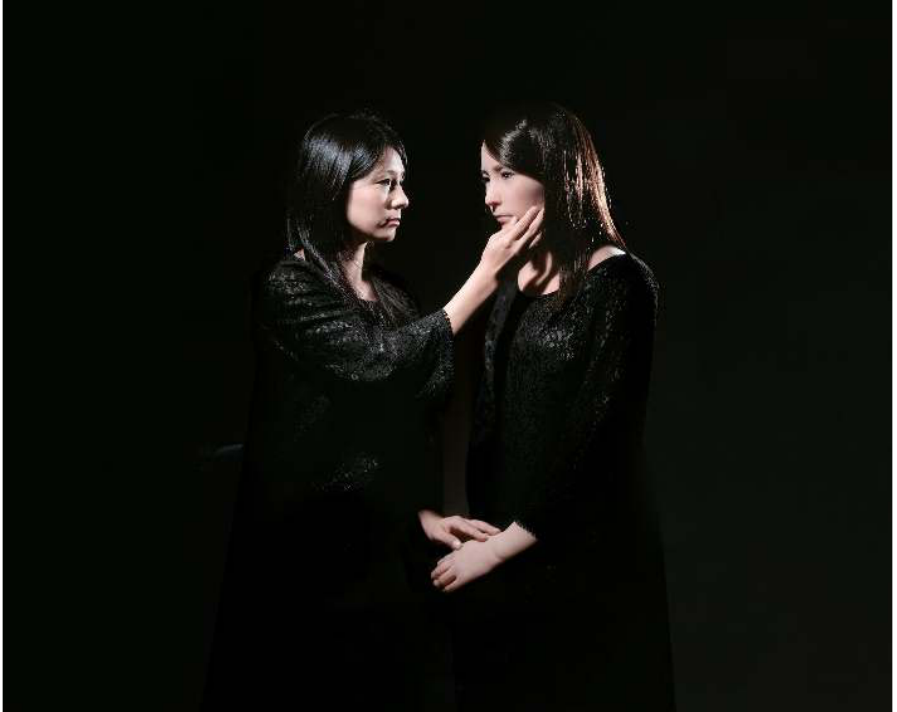
Figure 4: Max Aguilera-Hellweg, Geminoid F, humanoid series ,